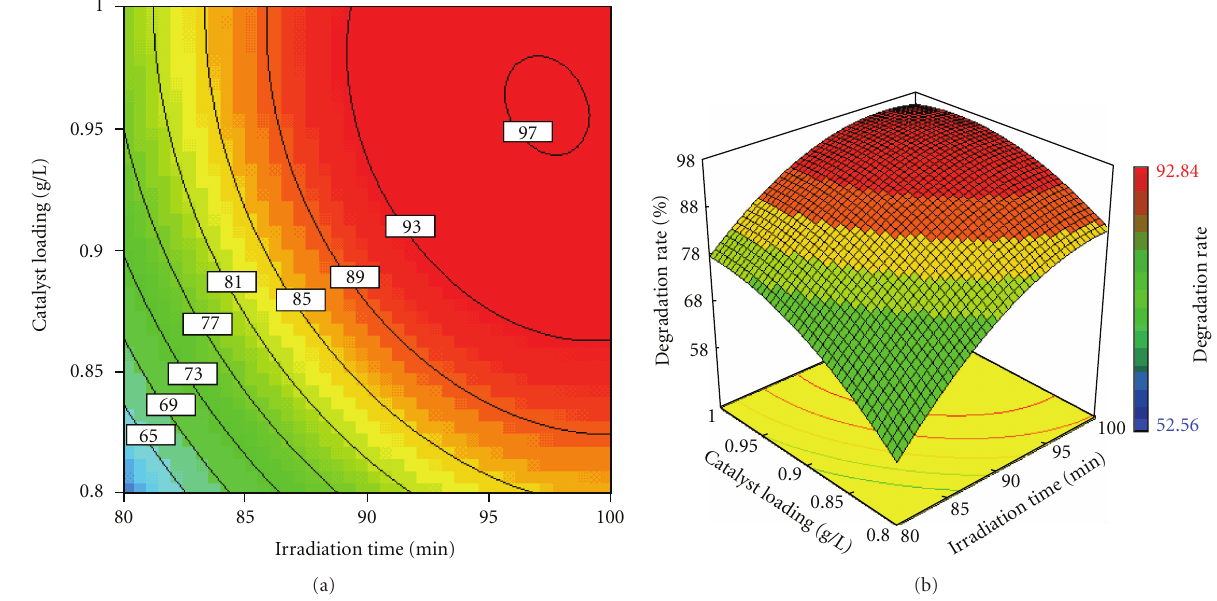
Figure 6: The response surface plot and the corresponding contour plot showing the e ff ects of irradiation time and catalyst loading on naphthalene degradation